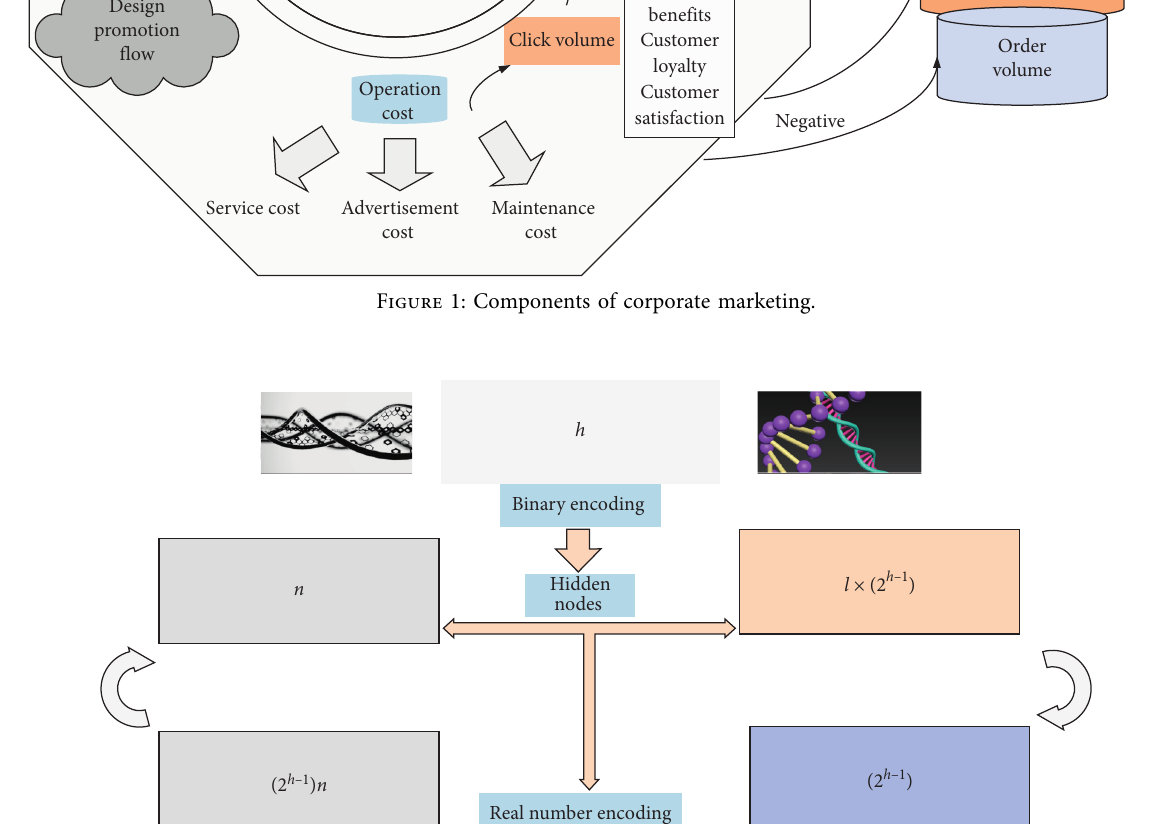
Figure 2: Gene coding and